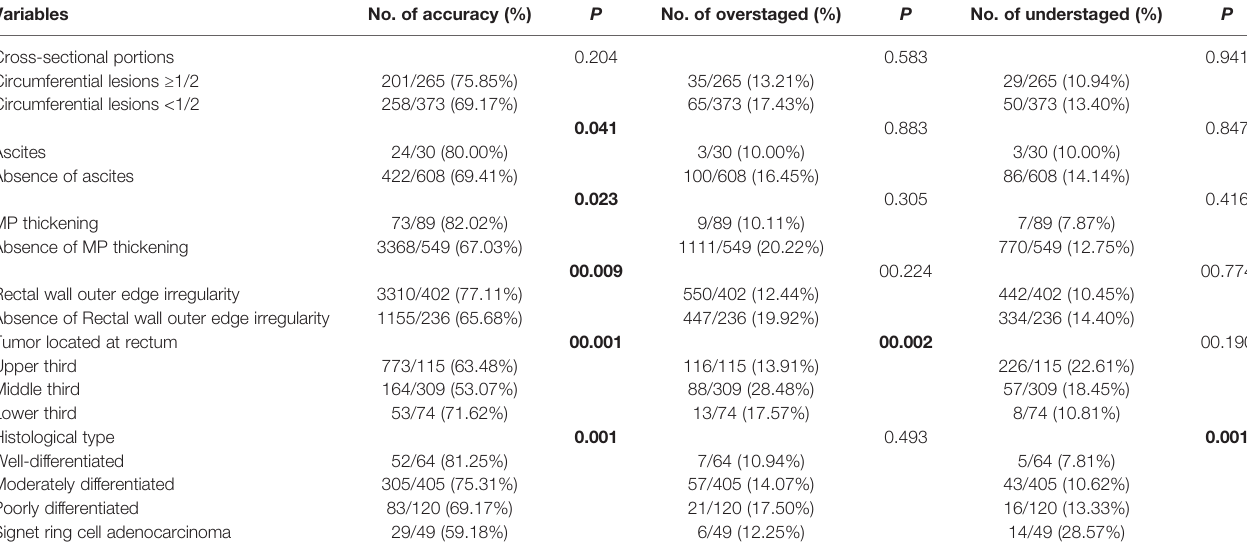
TABLE 4 | Factors affecting EUS T staging accuracy, overstaged and understaged according to clinicopathologic and endoscopic variables by univariate logistic regression analysis.